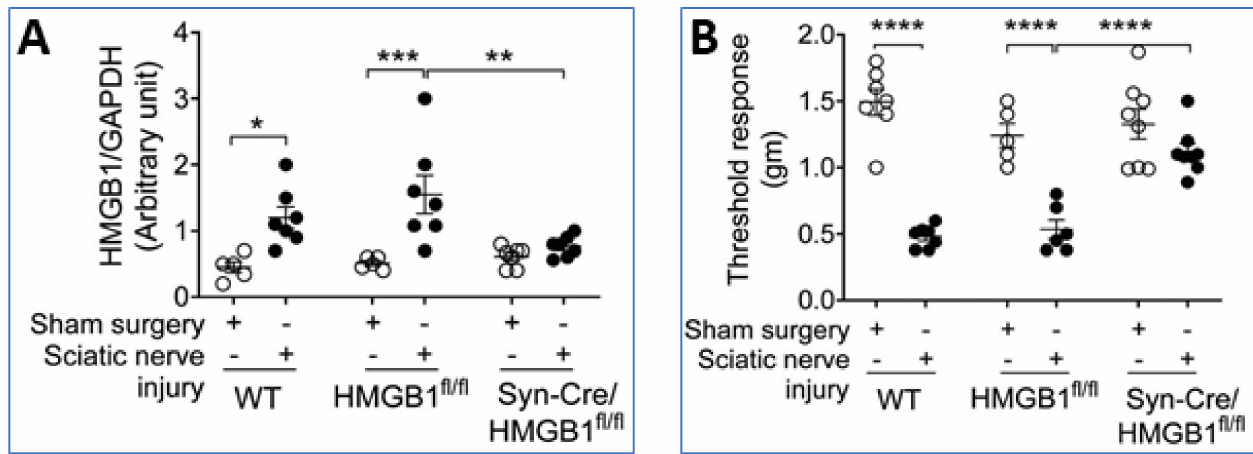
Figure 8. Ablation of neuronal HMGB1 reduces inflammation and hyperalgesia after sciatic nerve injury. Standardized sciatic nerve injury was induced via nerve ligation. ( A ) HMGB1 levels were significantly increased in paw tissue from WT and HMGB1 fl/fl control mice in contrast to Syn-Cre/ HMGB1 fl/fl mice (* p < 0.05, ** p < 0.01, *** p < 0.001). ( B ) Mechanical sensitivity assessed using von Frey filaments and the Dixon up-down method to calculate the threshold response demon- strated that hyperalgesia after sciatic nerve injury was significantly reduced in Syn-Cre/HMGB1 fl/fl mice as compared to HMGB fl/fl control mice (**** p < 0.0001). Reproduced from Yang et al.